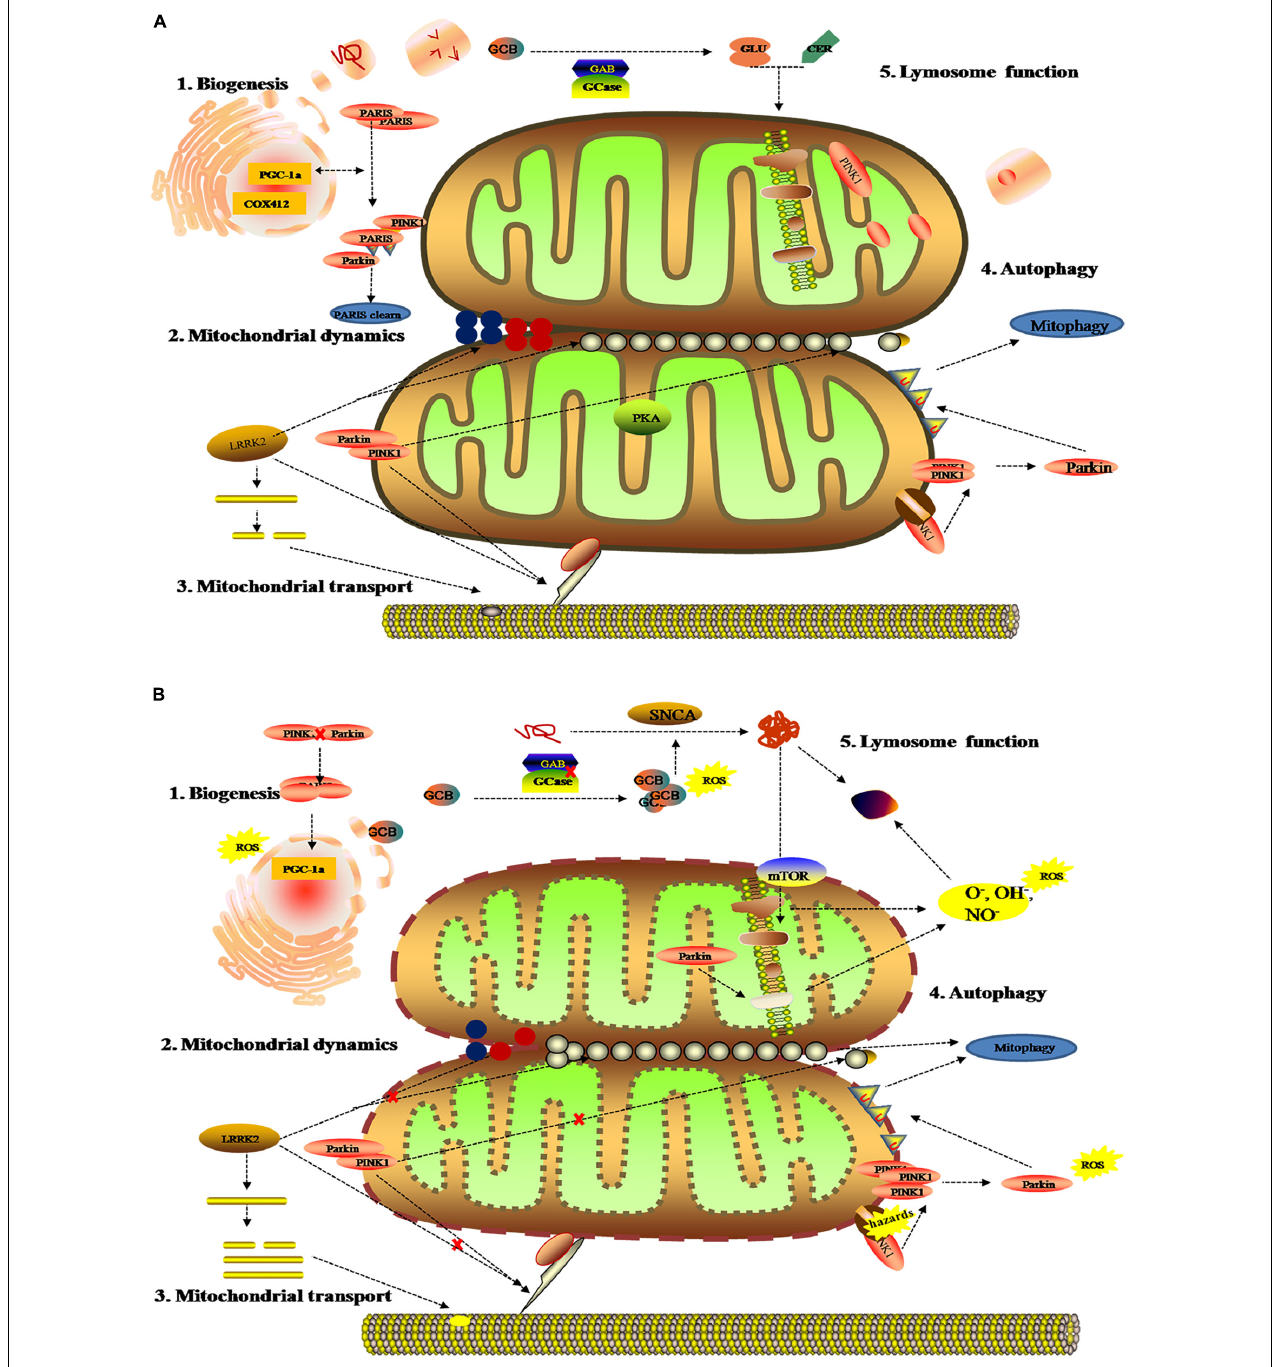
FIGURE 3 | Mitochondrial metabolomics in PD patients. (A) Under normal status: 1. mitochondrial complex IV subunit 4 isoform (COX4I2) and proliferator-activated receptor gamma coactivator 1- α (PGC1 α ) facilitate mitochondrial biogenesis. Additionally, PINK1 and Parkin alleviates PARIS toxicity by phosphorylation and ubiquitination, respectively. 2. PINK1 acts on dynamin-related protein 1 (DRP1) to regulate mitochondrial fission and PKA (PINK1 inhibits protein kinase) inhibits the progress. As such, LRRK2 is also involved in mitochondrial dynamic by MFNs and OPA1 (two mitochondrial fusion proteins) as well as DRP1 (a mitochondrial fission protein). 3. PINK1, Parkin, and LRRK2 mediate mitochondrial transport. 4. PINK1/Parkin clears damaged mitochondria by mitophagy (B) . Under gene mutant: 1. mitochondrial biogenesis is inhibited by upregulating PGC1 α , which is vulnerable to ROS. 2. The imbalance of mitochondrial dynamics. 3. The mutation of